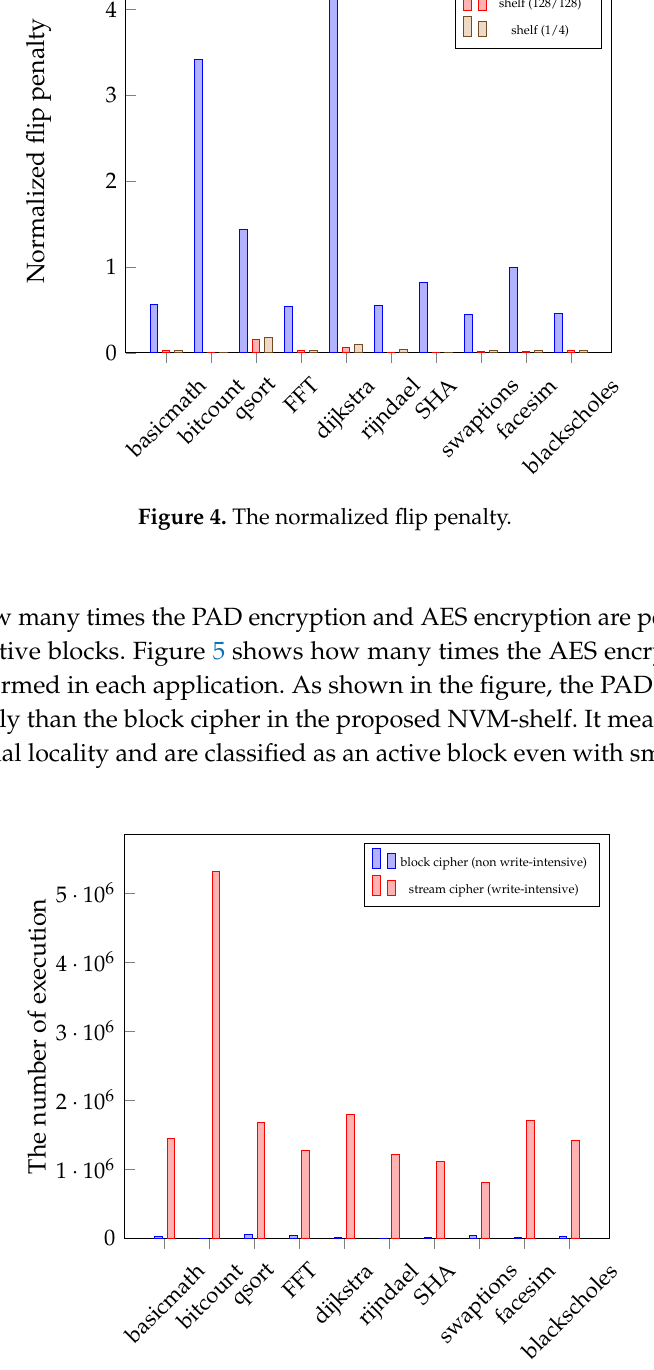
Figure 5. Encryption type occupation in